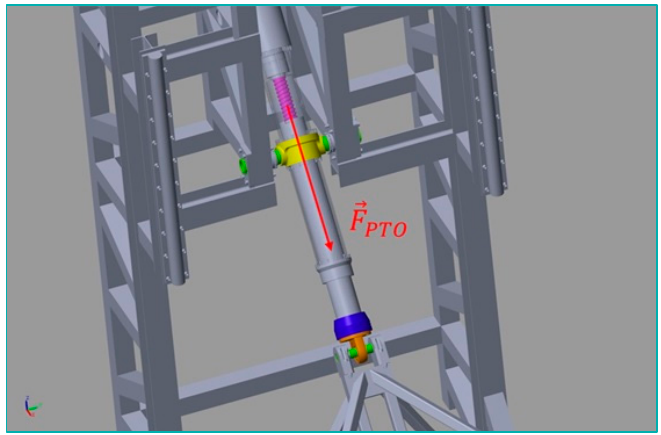
Figure 5. Axial force within the PTO module.